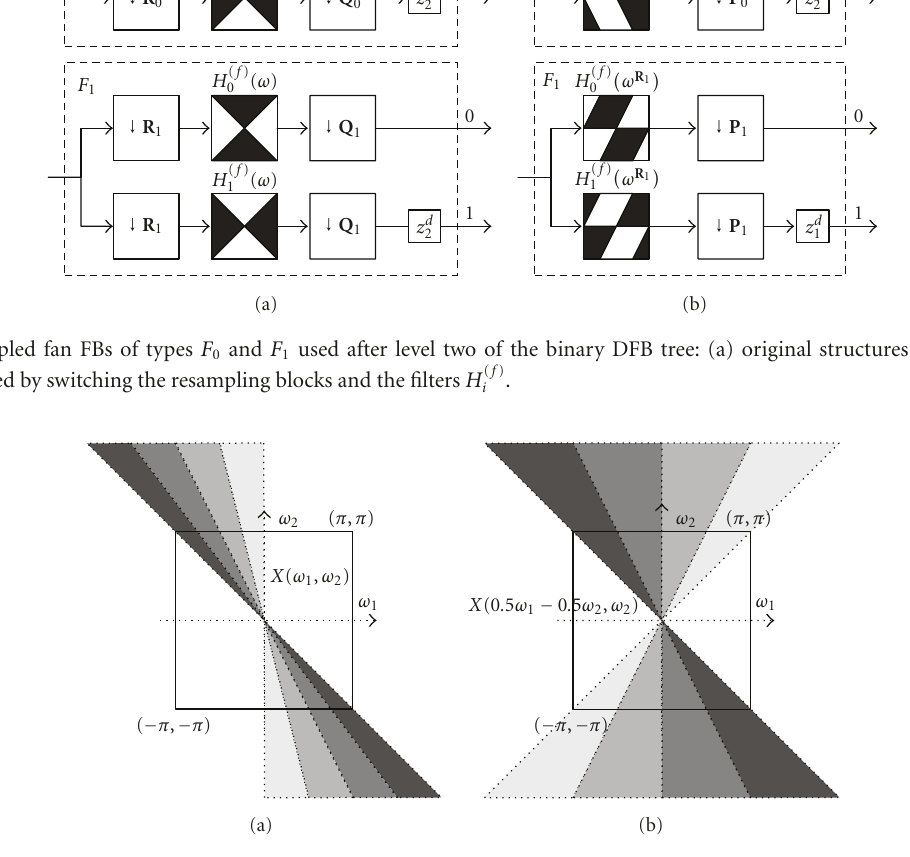
Figure 4: Illustration of frequency mapping when a 2-D signal X ( ω ) is downsampled by P 0 , (a) X ( ω ) is the subband 0 in a four-band DFB in Figure 1(a) decimated by 2 I , (b) the support of X ( P − T 0 ω